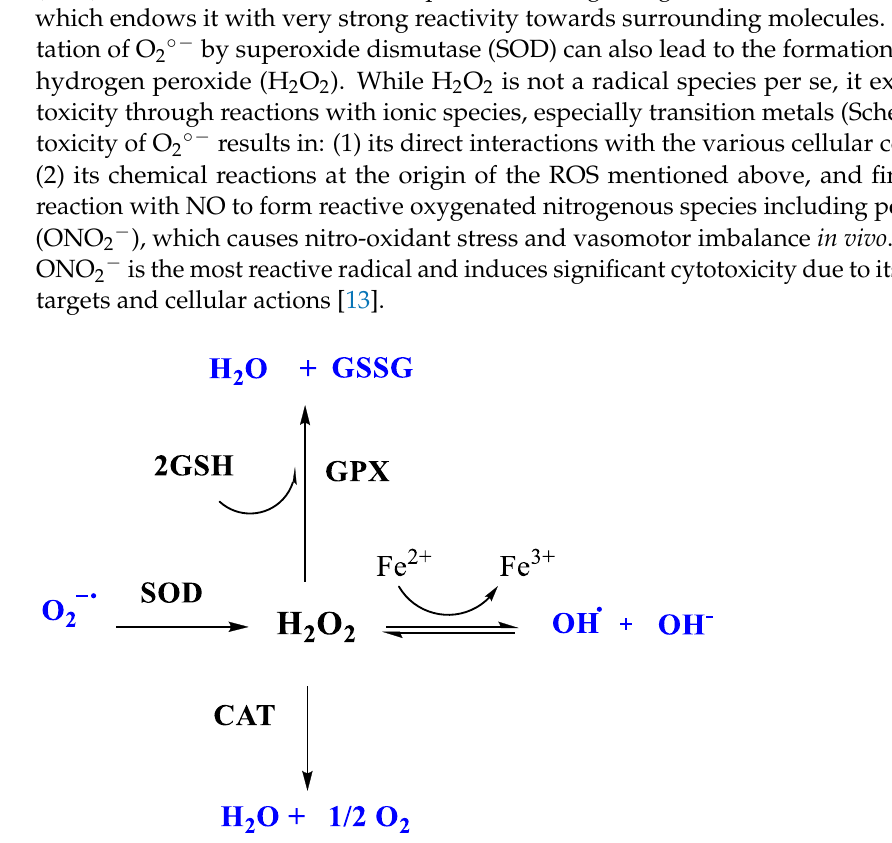
Scheme 1. Concepts of ROS generation and antioxidant control in DNA injury.